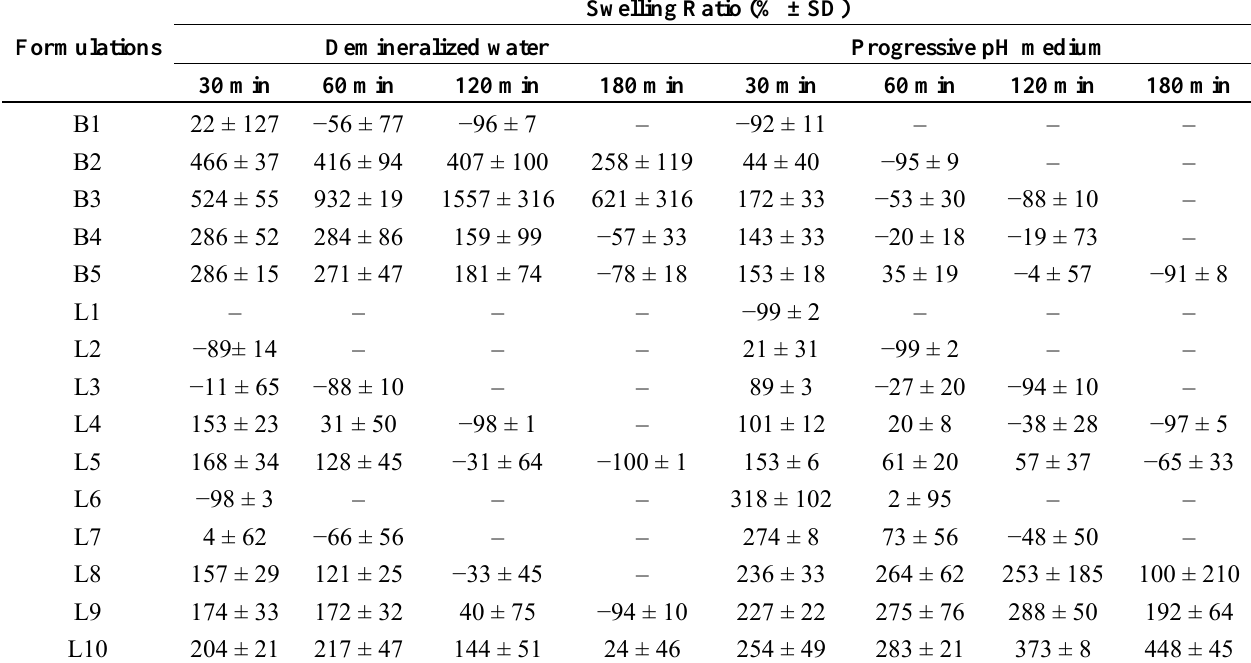
Table 2. Swelling Ratios of all lyophilized systems at specific time intervals (30, 60, 120 and 180 minutes) in demineralized water and in progressive pH medium (1.5 → 4 → 6.8).